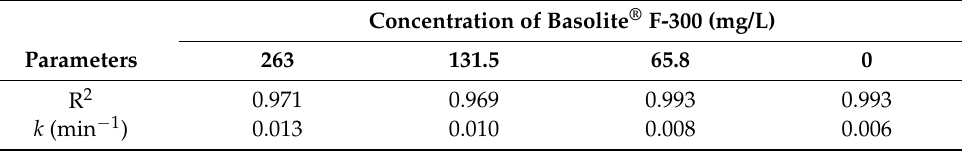
Figure 5. Representation of the antipyrine’s degradation profile for four different concentrations of Basolite ® F-300 (circle: 0 mg/L, triangle: 65.8 mg/L, square: 131.5 mg/L, and diamond: 263 mg/L). All experiments were performed with the same concentration of PMS (307.4 mg/L) and antipyrine (50 mg/L). The figure inside represents the kinetic model fittings at each Basolite ® F-300 concentra- tion. Data represent the mean values for triplicate samples with a standard deviation below 5%. Table 6. First-order kinetics of antipyrine degradation, with a concentration of 50 mg/L in the presence of PMS (307.4 mg/L) and a certain concentration of Basolite ® F-300 (0–263